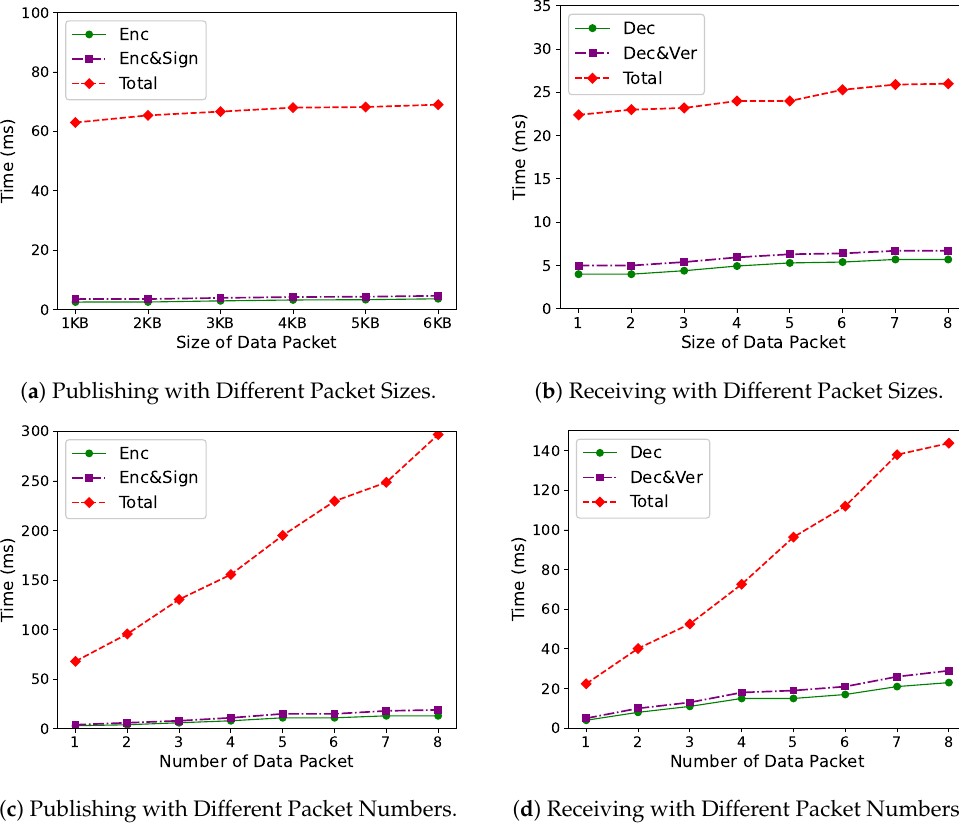
Figure 9. Performance of Publishing/Receiving a Message with Different Packet sizes and